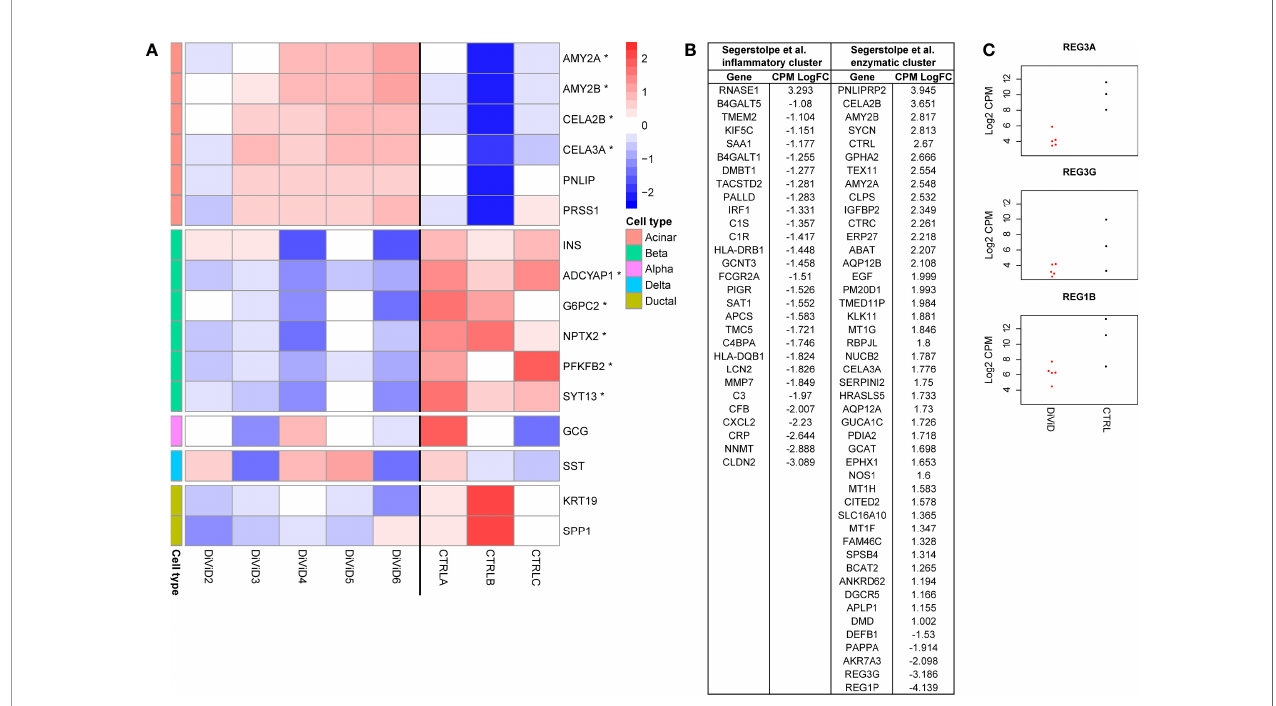
FIGURE 2 | (A) Z-score normalized expression of marker genes, and selected genes enriched in the different pancreas cell types (29, 34) that are also differentially expressed (* false discovery rate of ≤ 0.05 and a fold change of ≥ 2) in the whole pancreas transcriptome 1. CTRLA refers to the Agilent commercial control (non- diabetic organ donor), CTRLB refers to the Ambion commercial control (non-diabetic organ donor) and CTRLC refers to the commercial Clontech control (non- diabetic organ donor). (B) Differentially expressed genes in the whole pancreas transcriptome 1 associated with the two different acinar cell subpopulations suggested by Segerstolpe et al. (29). (C) The log 2 transformed counts per million (CPM) expression of three Reg-family genes in the whole pancreas transcriptome 1. Red color = samples from the DiViD patients, black color = samples from non-diabetic organ